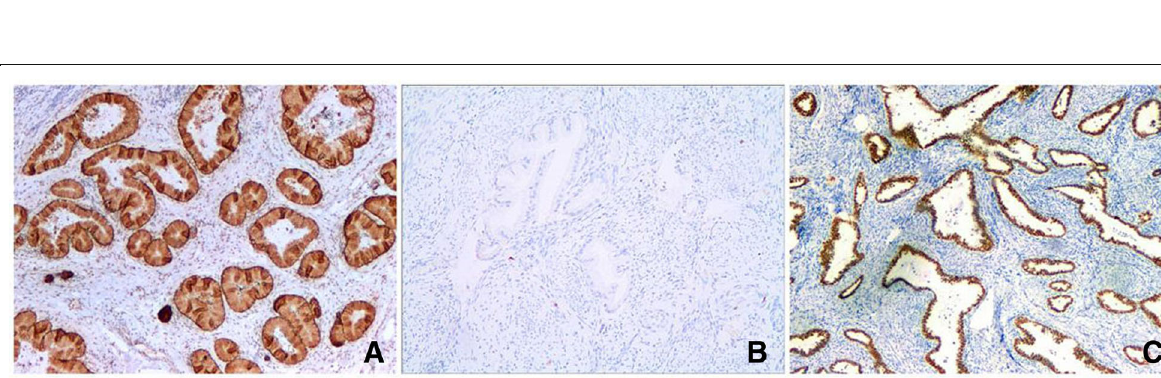
Fig. 3 a Gastric-type adenocarcinomas (GAS) with diffuse positivity with MUC6. b GAS displays negative immunoreactivity with p16. c GAS shows diffuse p53 positivity (H&E,